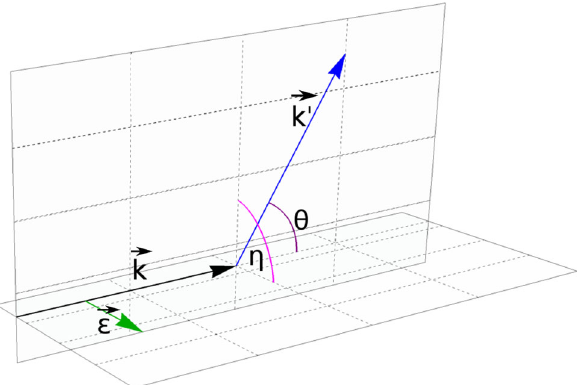
Fig. 3 Scheme of Compton scattering. An incident photon with momentum k scatters on an electron resulting in a change of its momen- tum k (cid:2) . The Compton scattering angle is denoted by θ . Initial and scat- tered momenta form a plane, which will be referred to as scattering plane. The incident photon momentum k and its linear polarization vector ˆ (cid:2) form a second plane, referred to as the polarization plane. The angle between those two planes is denoted as η